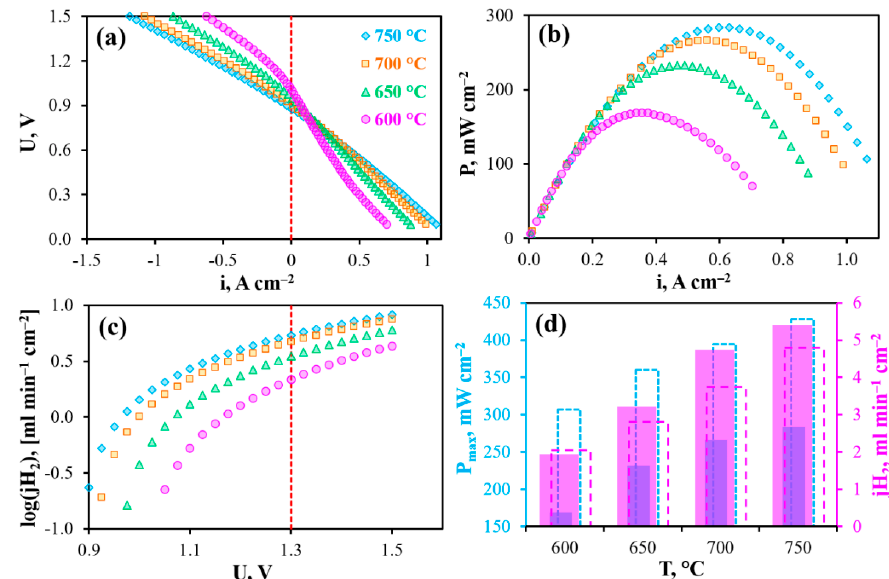
Figure 9. Reversible operation of the PCC at different temperatures under 50%H 2 O/H 2 —50%H 2 O/air conditions: volt-ampere curves ( a ), power density characteristics ( b ), maximal achievable hydrogen flux density ( c ), maximal power density and hydrogen flux density at U = 1.3 V depending on temperature compared with those (dashed columns) obtained under 3%H 2 O/H 2 —3%H 2 O/air conditions ( d ).